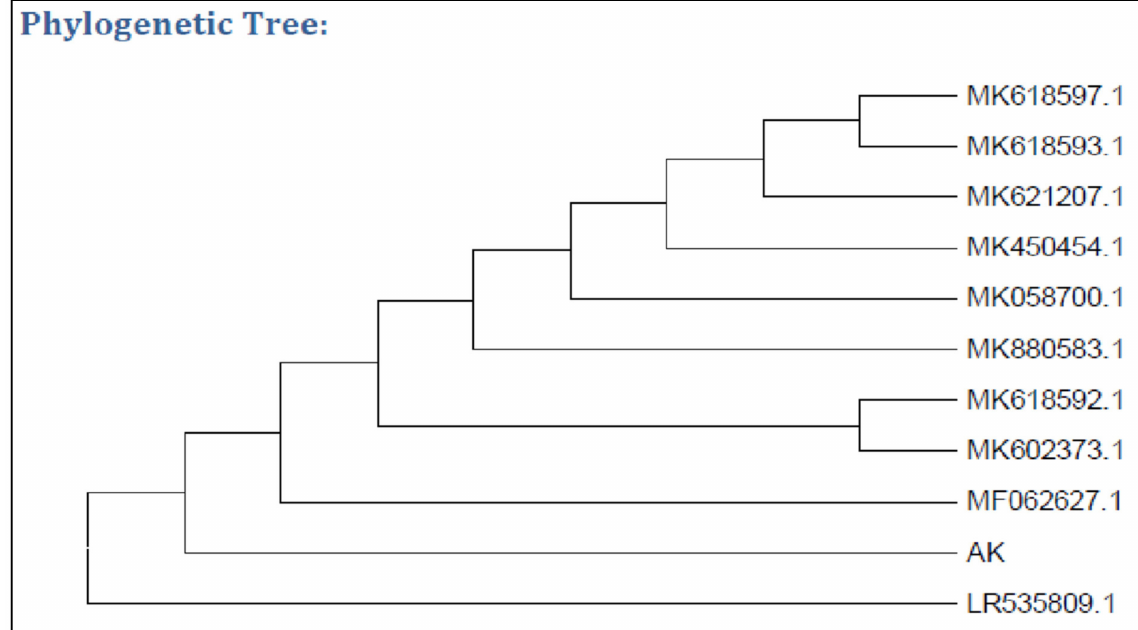
Figure 2. Phylogenetic tree showing the position of isolated bacterium